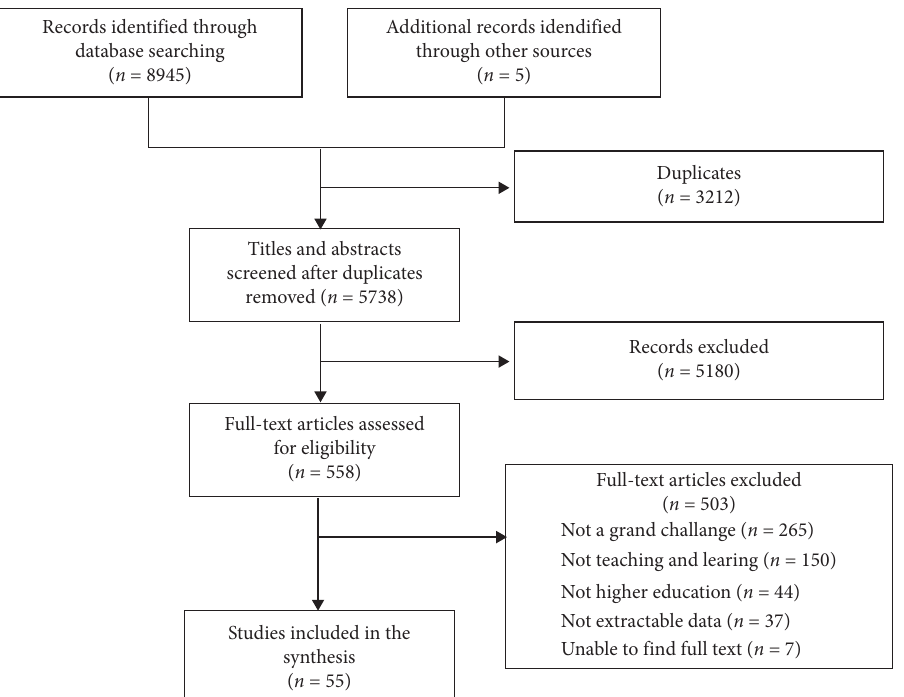
Figure 1: PRISMA flow